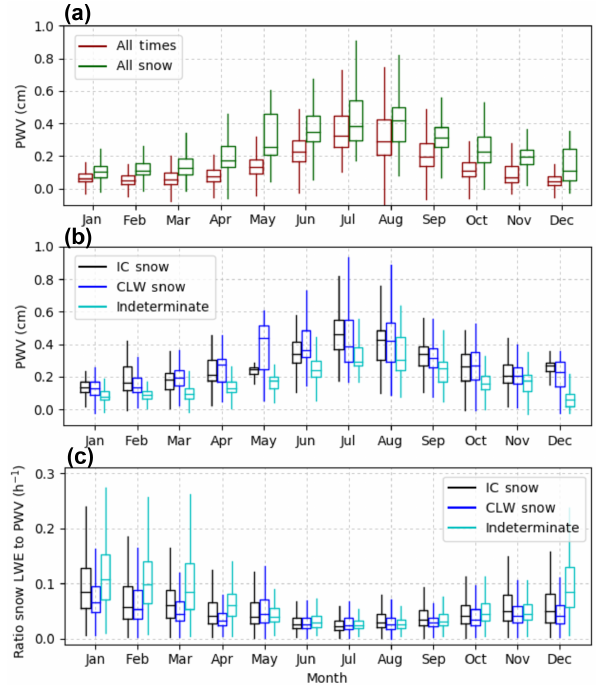
Figure 4. The POSS statistics from 2010–2015 for the MWR fil- tered precipitation events. Panel (a) shows snow amounts by occur- rence (POSS) for all data: IC – 30.5%, CLW – 48.5%, and inde- terminate – 21%. Panel (b) shows snow amounts by accumulation (POSS) for all data: IC – 35%, CLW – 51%, and indeterminate – 14%. The POSS snowfall amounts and snow rates were calculated using the Sheppard and Joe (2008) Z to S relationship. Panel (c) shows the POSS LWE snow rate (mmh − 1 ) as a function of snow classification by month in a box and whisker plot: means (horizon- tal line), 25th to 75th percentiles (box), and 5th to 95th percentiles (vertical line). (Note: c shows very high values for the CLW snow in May, which is due to an unusually large storm dominating the results).